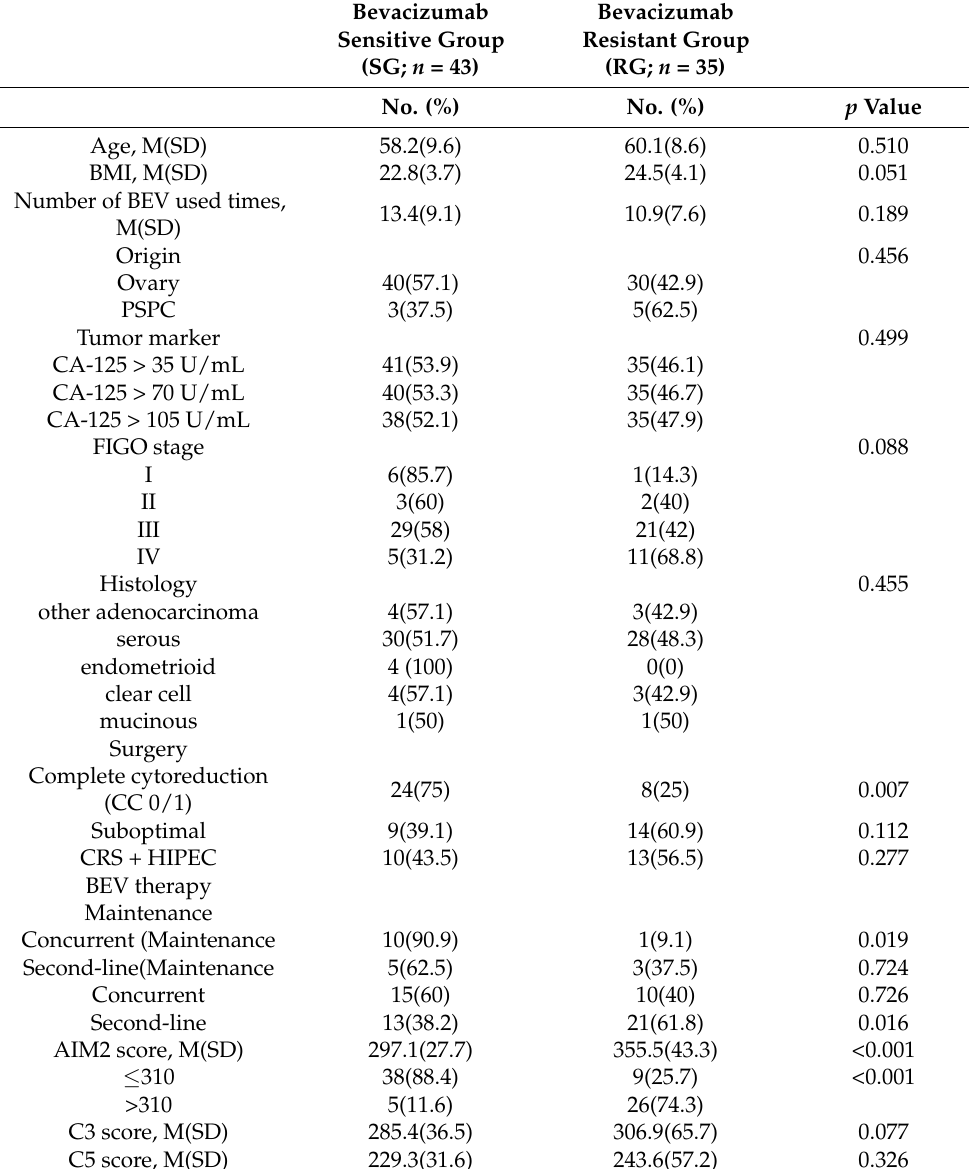
Table 1. Association between bevacizumab efficacy and clinicopathological